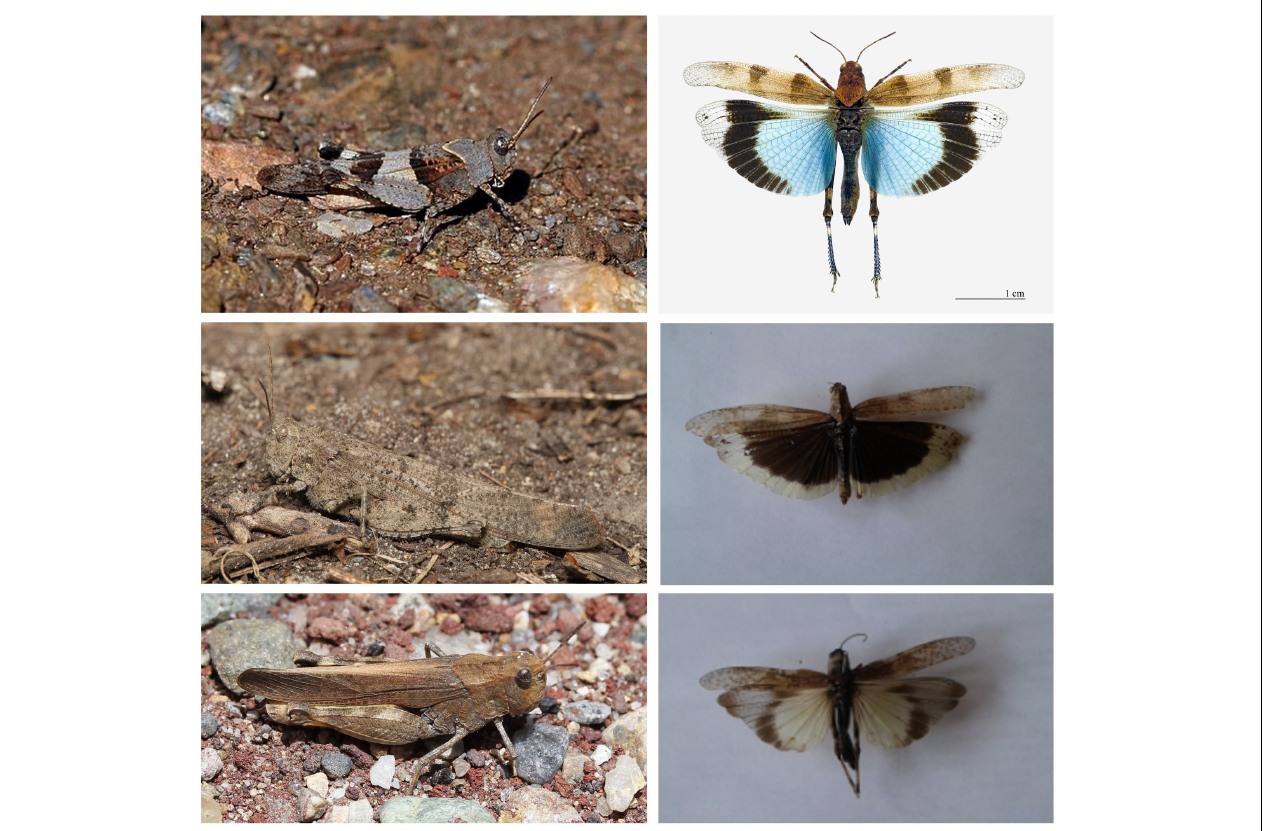
FIGURE 1 | Examples of flash behavior in Orthoptera (grasshoppers and crickets). Many grasshoppers are cryptic at rest and have transparent wings when they fly. However, the blue-winged grasshopper Oedipoda caerulescens (Linnaeus) exposes bright blue wings when flying, before settling into a cryptic resting state (row 1). The Carolina locust Dissosteira carolina (Linnaeus) exposes dark brown wings in flight yet resumes crypsis when it settles (row 2). Similarly, the short-horned grasshopper Arphia conspersa (Scudd) flashes conspicuous yellow wings in flight (row 3). The images (except those provided by KL-H) were derived from Wikimedia Commons and are reproduced under the Creative Commons Licence. Photo credits (by row, left and right): (1) Charles Sharp, Didier Descouens; (2) anonymous, Karl Loeffler-Henry; (3) Even Dankowicz, Karl